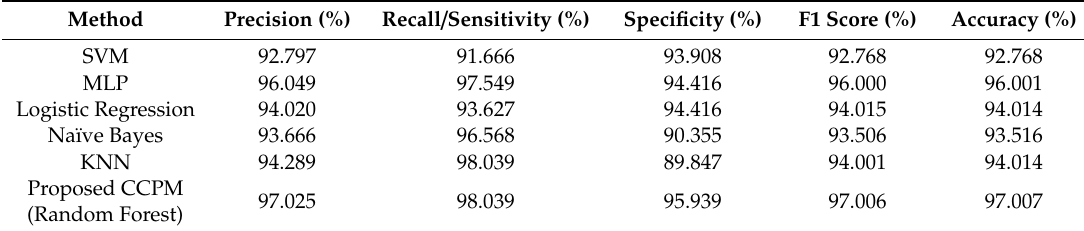
Table 6. Performance evaluation results based on density-based spatial clustering of applications with noise (DBSCAN) and SMOTE for Biopsy.